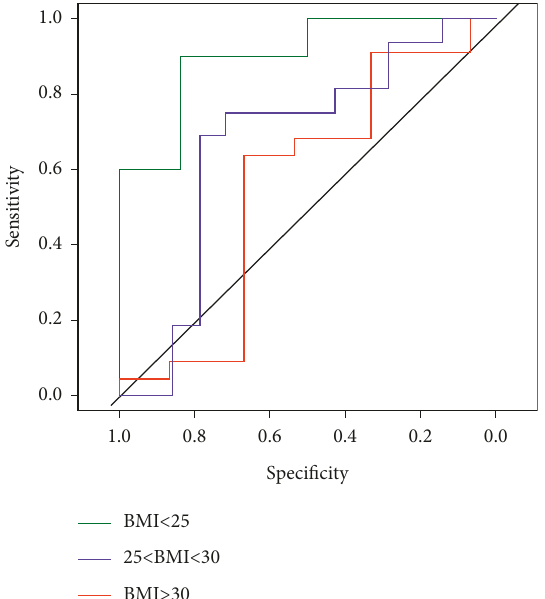
Figure 2: Discriminatory value of Adpn/Lep for COVID-19 pneumonia. Adpn/Lep receiver operator characteristic curves illustrating the ability of Adpn/Lep to identify COVID-19 pneumonia after BMI stratification. Table 2: Logistic multivariate regression models evaluating the association of leptin and Adpn/Lep with COVID-19 pneumonia. Dependent variable: presence of COVID-19 pneumonia